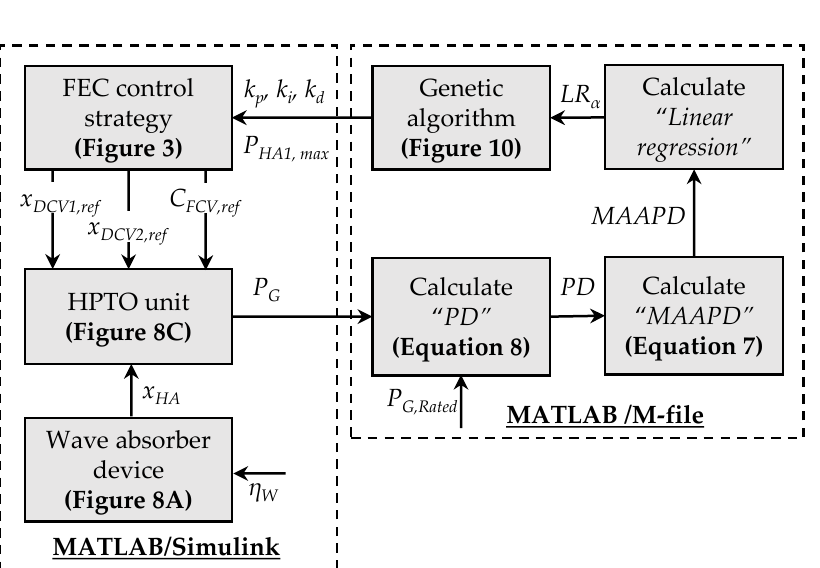
Figure 9. Illustration of simulation set-up for optimization of control strategy using genetic algorithm in MATLAB